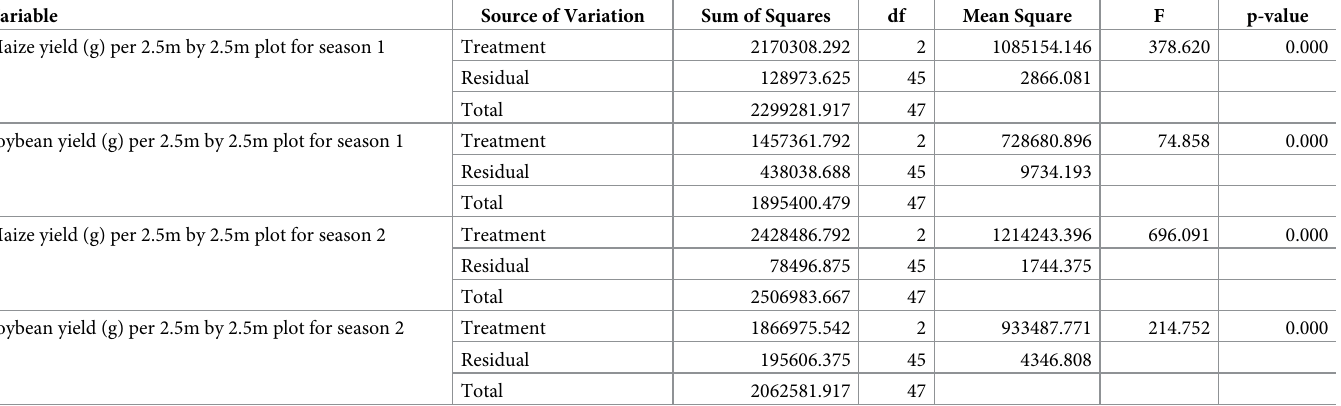
Table 1. Analysis of variance results.